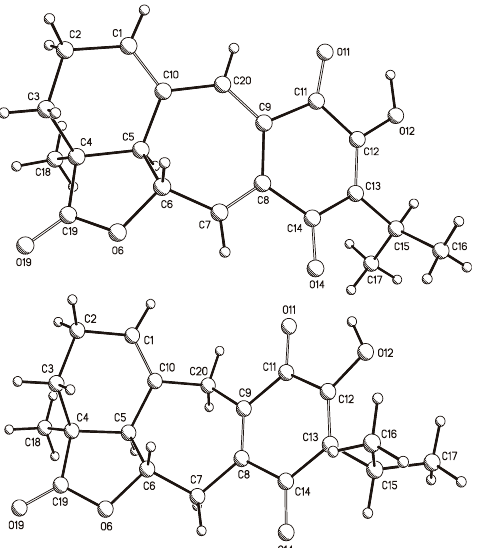
Figure 8. PLUTO plots of the single crystal X-ray diffraction structures of anastomosine ( 6 , top ) and of 7,20-dihydroanastomosine ( 7 , bottom ). 7,20-dihydroanastomosine ( 7 , bottom